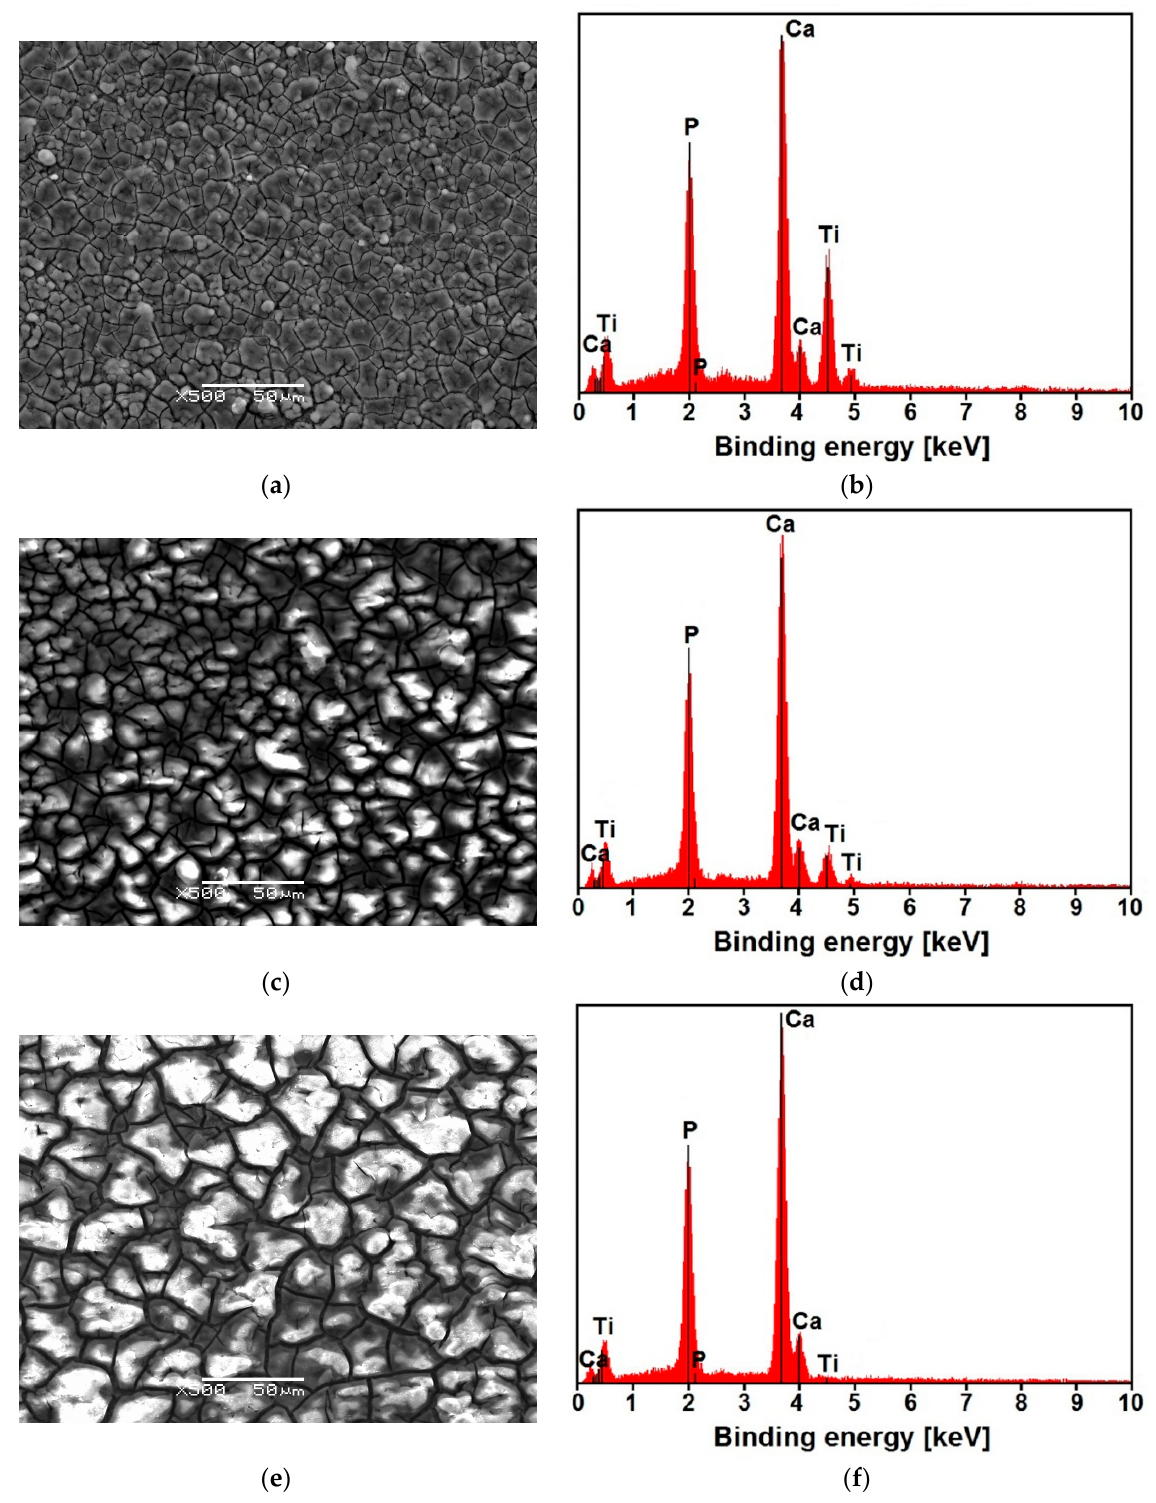
Figure 6. SEM image of the surface morphology with the corresponding EDS spectrum for the CaP coating deposited at − 10 V at 20 °C for: ( a , b ) 20 min; ( c , d ) 30 min; ( e , f ) 40 min.